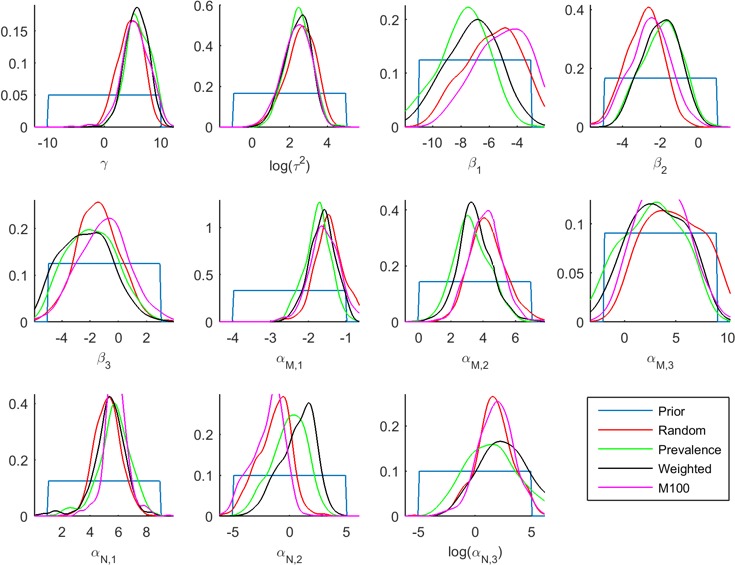
Posterior distributions of the parameter values from the ABC inference on the infections and co-infections under different modeling assumptions using data for 2012.Each panel shows the posterior distribution for one parameter under four different modeling assumptions. Red line shows the results under the standard assumptions used in other analyses. For the parameter γ, the standard choices produce more conservative (closer to 0) distributions than the others and the probability that γ>;0 is lowest, suggesting that the modeling assumptions have not led to an overestimation of the incidence of coinfections.